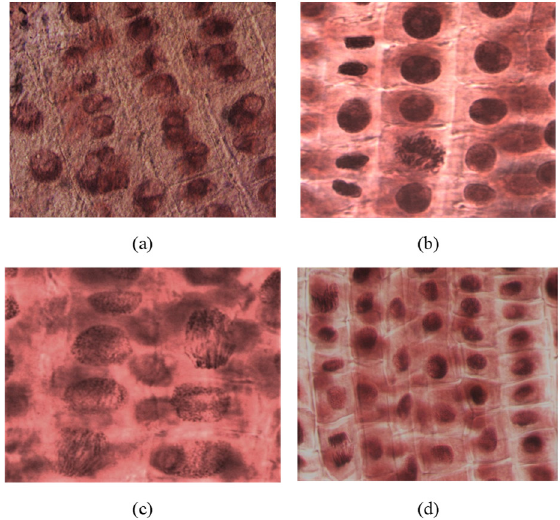
Figure 6. ( a ) Nuclei with hypertrophied nucleoli observed in rootlets treated with compound 2c (concentration of 1000 µ M); ( b ) metaphase in tropokinesis and normal telophases observed in rootlets treated with compound 4c (concentration of 1000 µ M); ( c ) telophase with chromosomal bridges observed in rootlets treated with compound 4a (concentration of 10 µ M); ( d ) telophase with delayed chromosomes, metaphases, and interphases observed in rootlets treated with compound 2b (concentration of 100 µ M). All microphotographs were taken with a lens magnified by 40 ×.